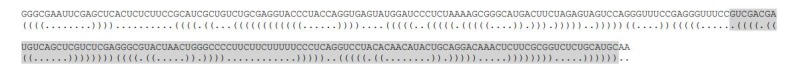
Optimal secondary structure prediction for 5i3